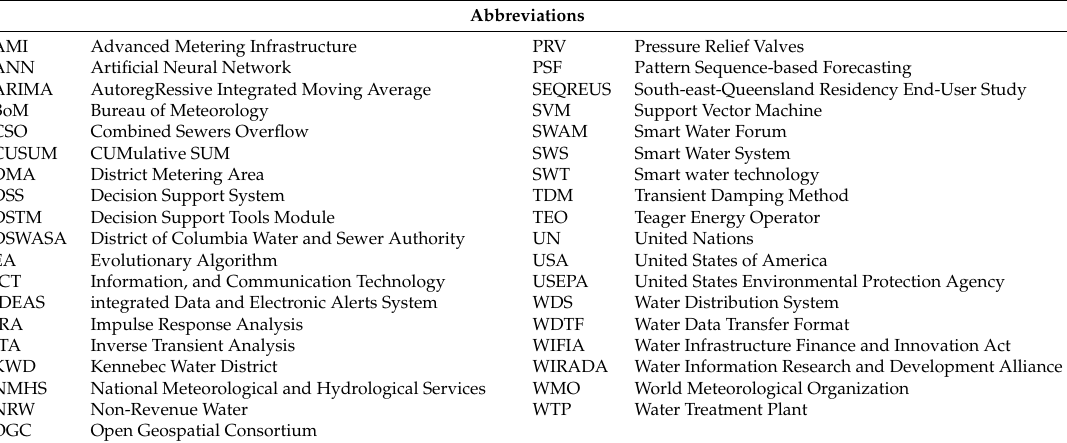
Table 1. List of abbreviations used in the paper.